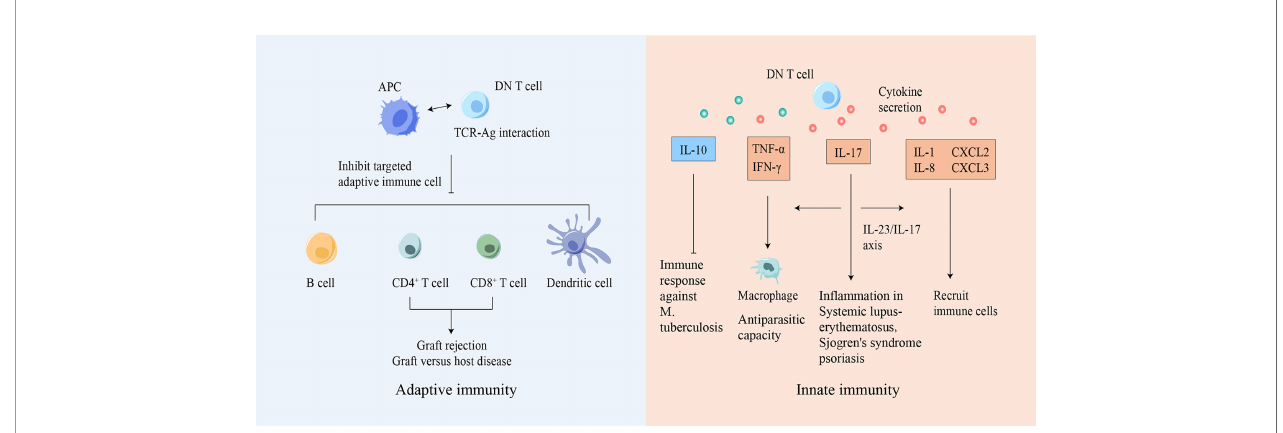
FIGURE 2 | DN T cells participate in both innate and adaptive immunity. Based on Ag-TCR-speci fi c recognition, DN T cells can inhibit or eliminate adaptive immune cells, suppressing diseases caused by immune responses. DN T cells can also secrete various cytokines to mediate innate immune responses. Ag, antigen; APC, antigen presenting cell; CXCL, chemokine ligand; DN, double-negative; IFN- g , interferon- g ; IL, interleukin; M. tuberculosis, Mycobacterium tuberculosis; TCR, T cell receptor; TNF, tumor necrosis